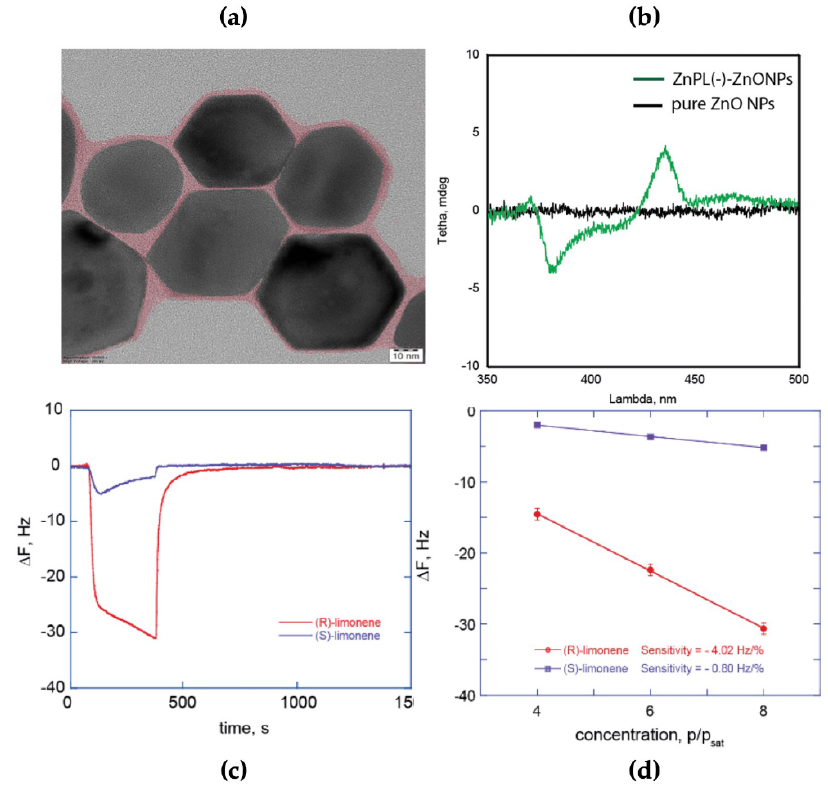
Figure 8. ( a ) TEM images of pyramidal ZnO nanoparticles capped by a layer of ZnP(L)Pro( − ) aggregates (artificially shown as a pink colour). ( b ) CD spectra of drop-casted material; black-trace, bare ZnO nanoparticles; red-trace, ZnO nanoparticles-porphyrin aggregates conjugates, evidencing the induced chiral feature of the zinc oxide surface (ca 375 nm). ( c ) Dynamic response of a QMB device with a layer of ZnO nanoparticles-porphyrin aggregates conjugates upon exposure to vapours of (R)-limonene (red-trace) and (S)-limonene (black-trace). ( d ) Plot of QMB responses at the different dilutions of the saturated vapour pressure of (R)-limonene (red trace) and (S)-limonene (black trace). Adapted with permission from [39], Copyright © 2019, American Chemical Society.